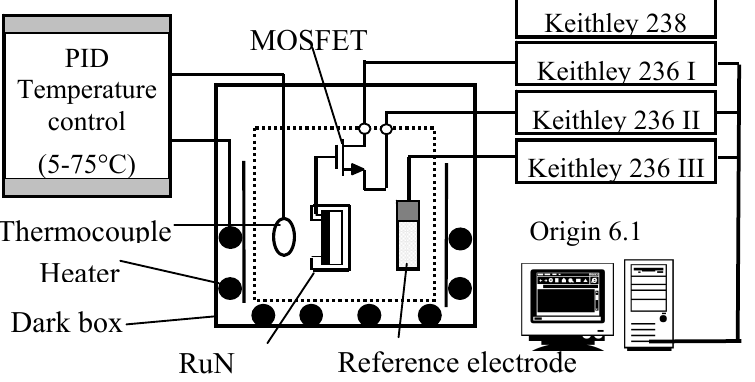
Figure 2. V-T measurement system used for the RuN sensing membrane pH